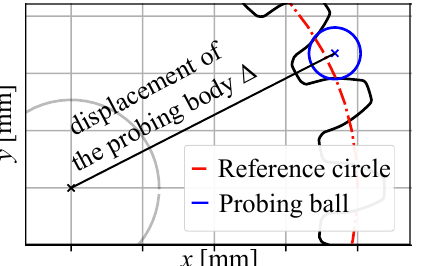
Figure 3. Determination of the displacement of the virtual probing body.